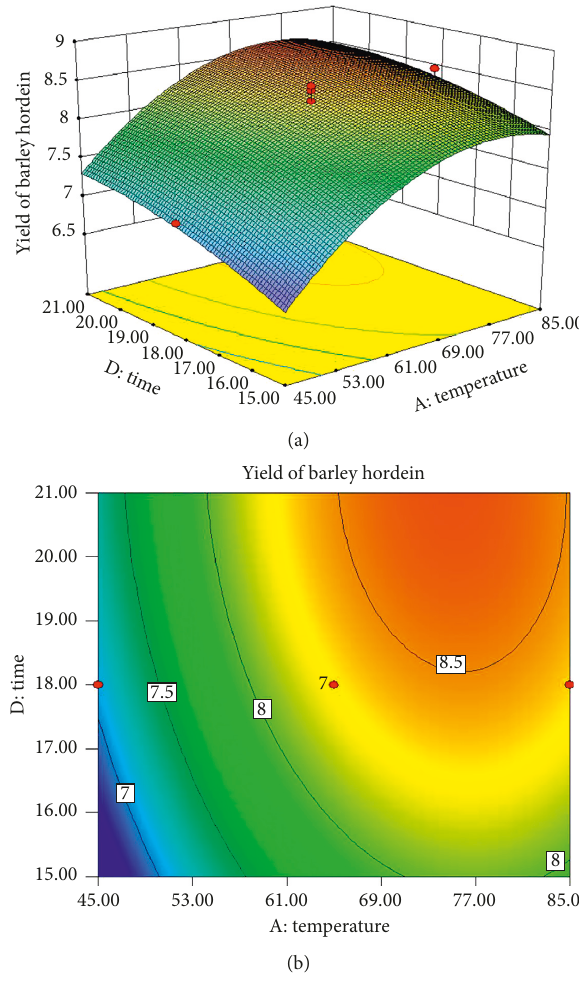
Figure 4: Response surface plot and contour plot showing the effect of temperature and extraction time on the yield of barley microwave power 255W and hordein at ultrasonic power